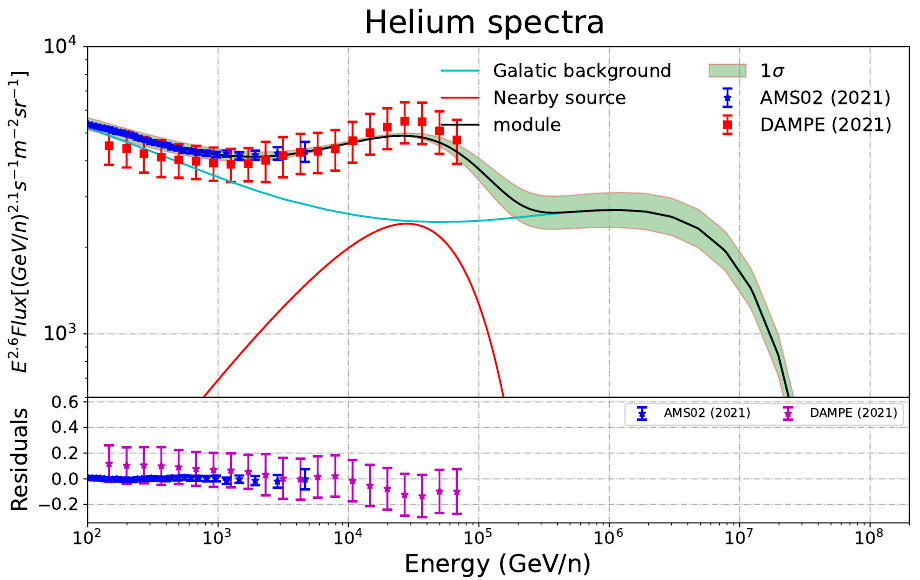
Figure 2. Proton and helium spectra fit result by mcmc combined with data. The cyan line is the energy spectrum of the galactic background. The red one is the local source inject spectra. The data points are taken from AMS-02 ([45]) and DAMPE ([16,46]).